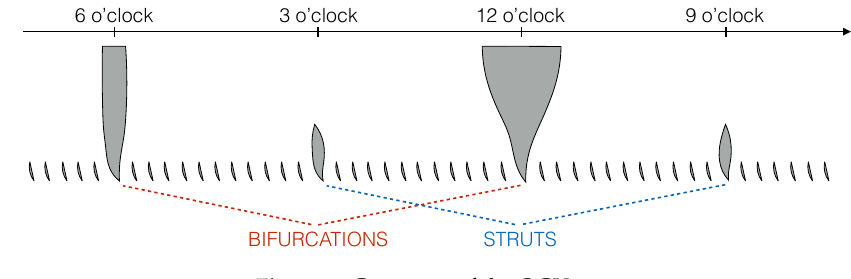
Figure 2. Geometry of the OGV